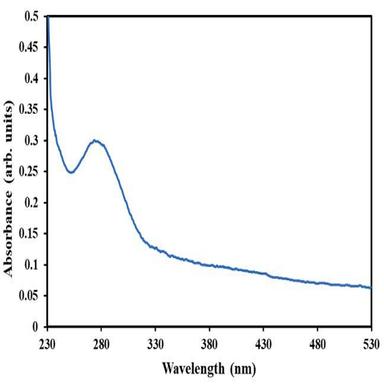
UV–Vis absorption spectra of CuO NPs dispersed in chloroform.